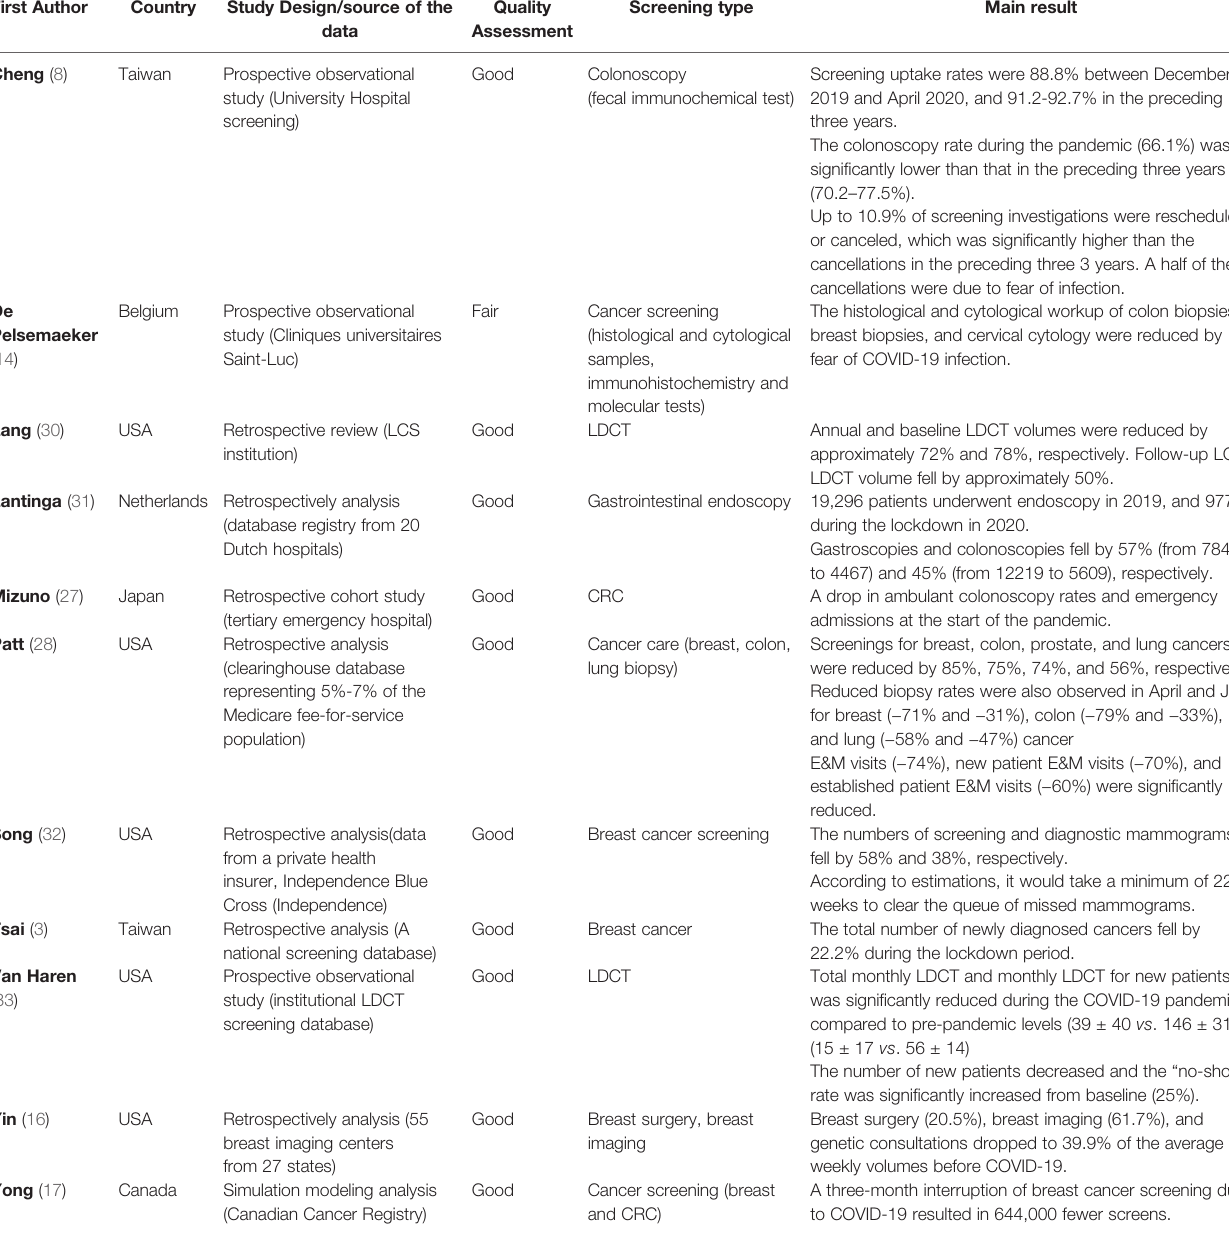
TABLE 1 | Impact of COVID-19 on cancer screening and pathology